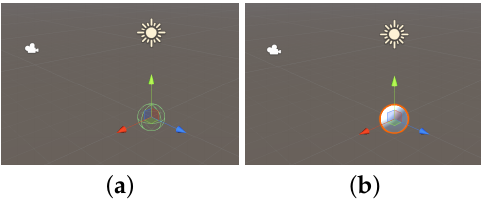
Figure 6. ( a ) Haptic interaction point object and ( b ) ideal haptic interaction point